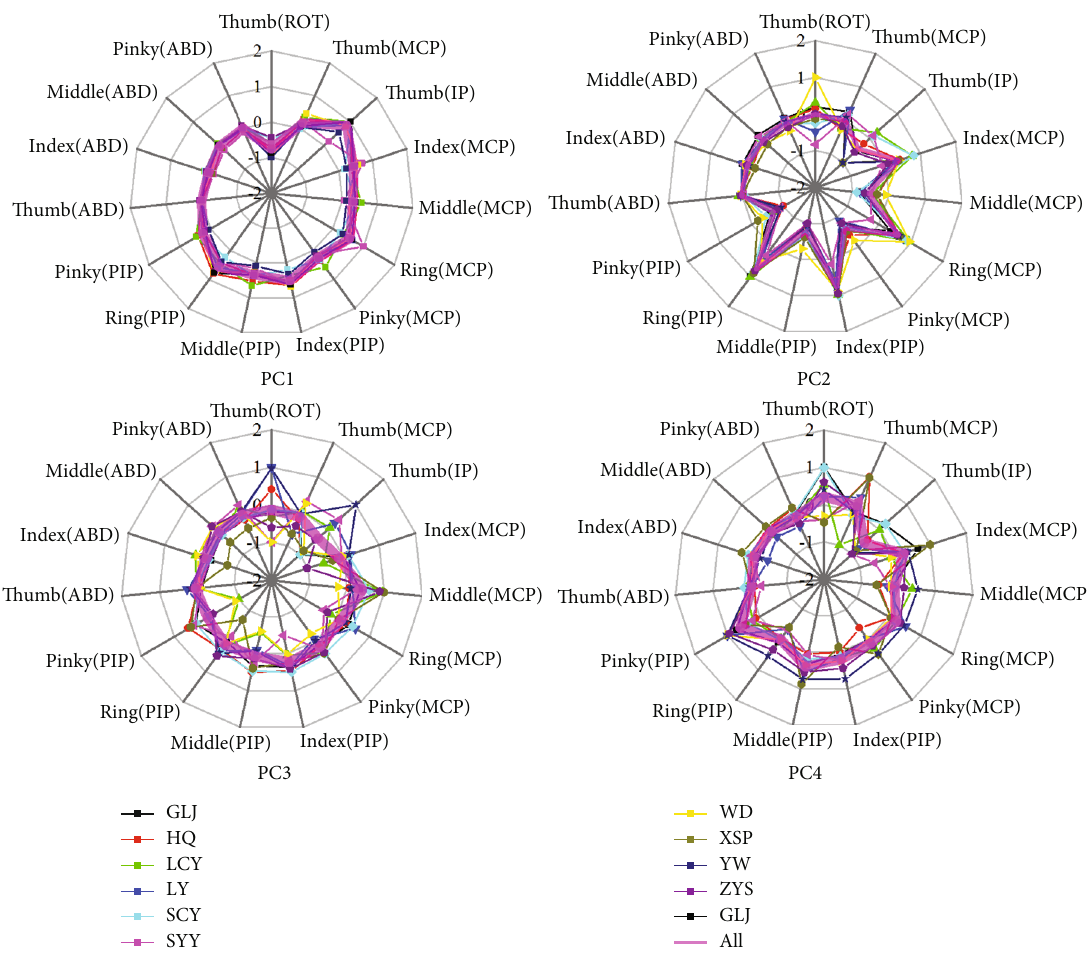
Figure 7: First four principal components of each subject. The principal components were normalized to allow intersubject comparison. The magenta thick lines in each sub fi gure represent the mean value of principal components across ten